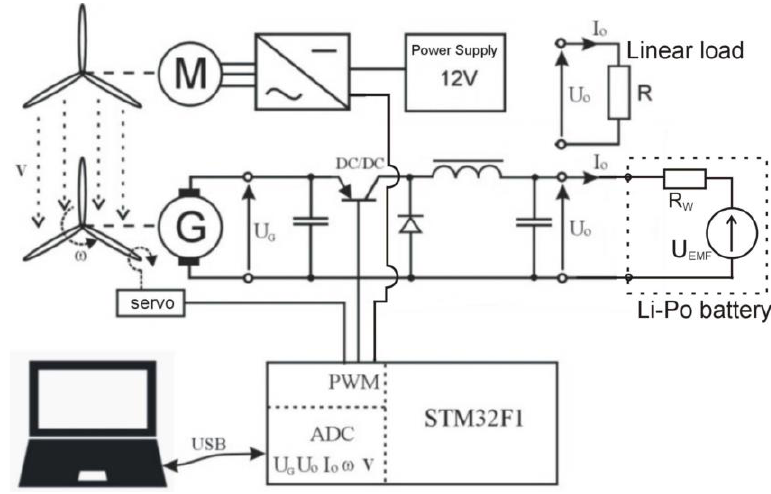
Figure 7. Schematic diagram of the stand for testing the wind microturbine model.